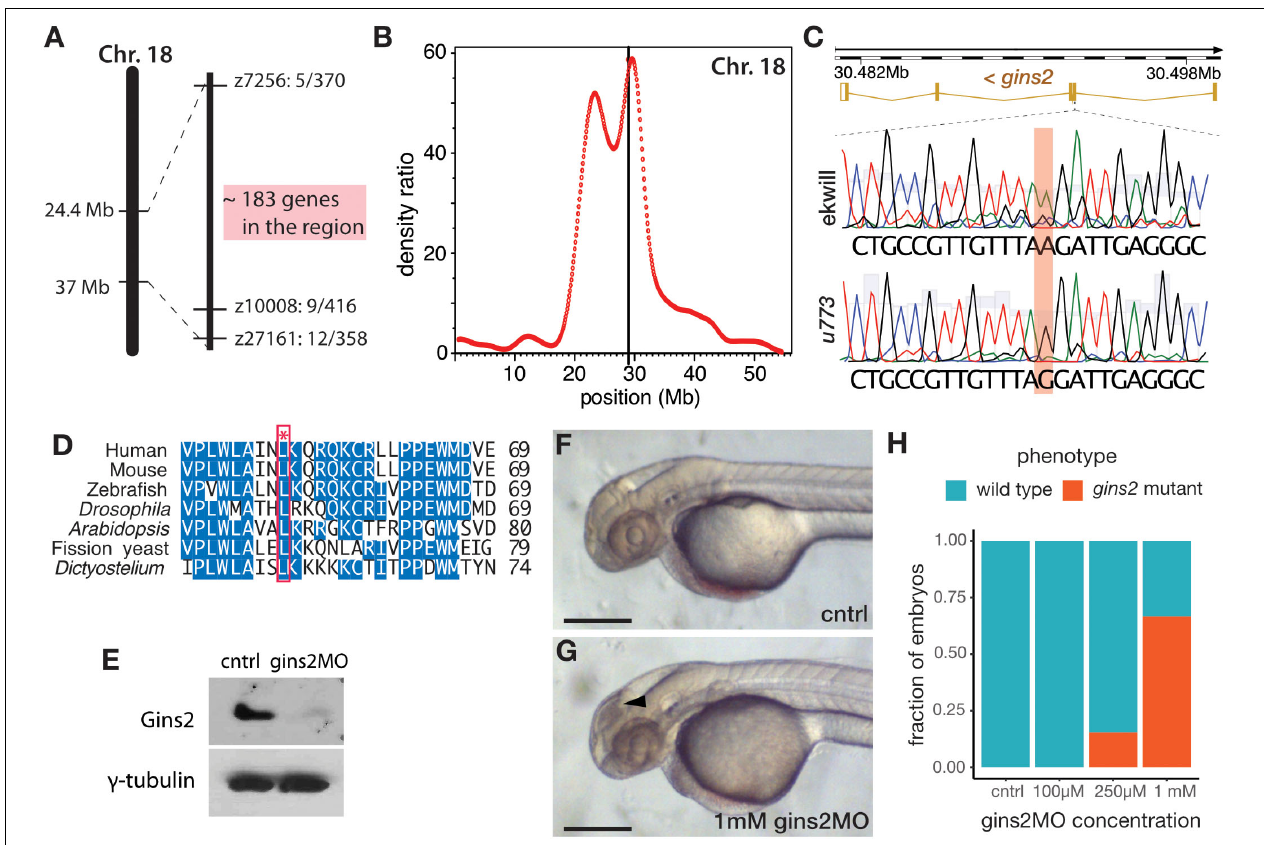
FIGURE 2 | u773 is a loss-of-function allele of gins2 . (A) Initial region of Chromosome 18 that segregated with the u773 mutant phenotype. (B) WGS mapping plot of SNP homozygosity on Chromosome 18. (C) Sanger sequencing results aligned to the reference sequence of gins2 for u773 mutants and ekwill controls. (Note that gins2 is on the reverse strand and the sequence is shown in the reverse direction). (D) Multiple sequence alignment of Gins2/Psf2 protein sequences in different species. The red box and asterisk denotes the lysine residue affected in u773 mutants. (E) Protein lysates from uninjected (cntrl) and gins2 MO-injected 2 dpf embryos were separated with SDS-PAGE and then subjected to western blotting with Gins2 and γ -tubulin antibodies. (F,G) Phenotype of 2 dpf gins2 MO injected embryos and uninjected controls (black arrowhead indicates dead cells). Scale bars: 250 µ m. (H) Graph showing the fraction of morphants showing the gins2 u773 phenotype at the indicated gins2 MO